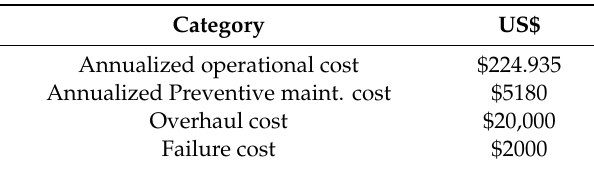
Table 12. Compressor’s Operating